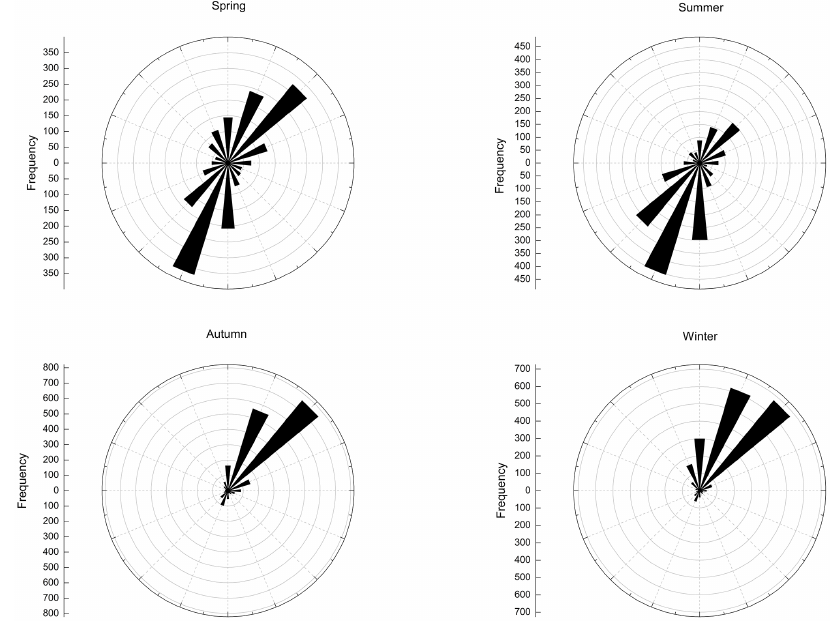
Figure 3. Wind rose diagrams for the frequencies of wind direction in each season from June 2011 to May 2012 at GPACS. Table 1. The wind speed and temperature in each season (from June 2011 to May 2012) at GPACS.